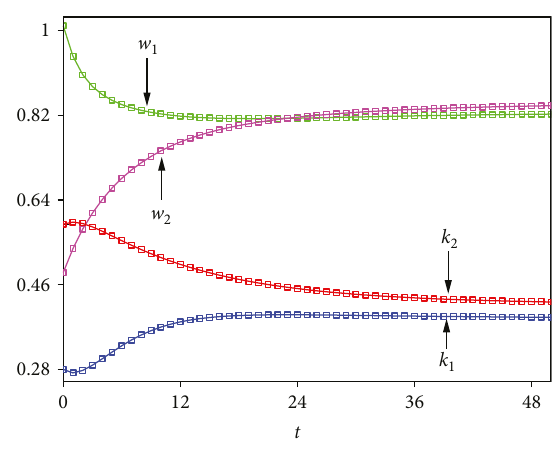
Figure 20: Time series of k 1 , k 2 , w 1 , w 2 in a stable state.